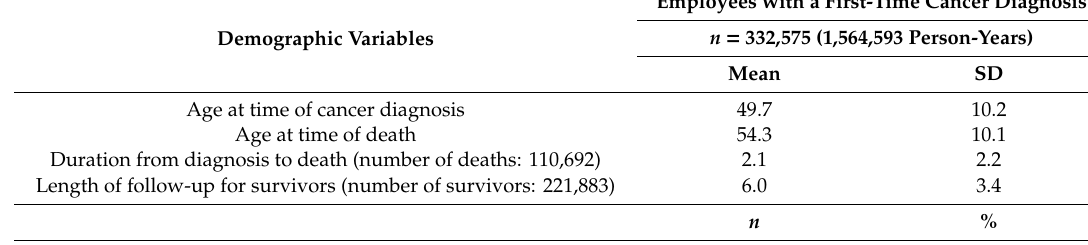
Table 4. Characteristics of insured workers with first-time cancer diagnosis in Taiwan, 2004–2015. Employees with a First-Time Cancer Diagnosis n = 332,575 (1,564,593 Person-Years) Demographic Variables Mean SD Age at time of cancer diagnosis 49.7 10.2 Age at time of death 54.3 10.1 2.1